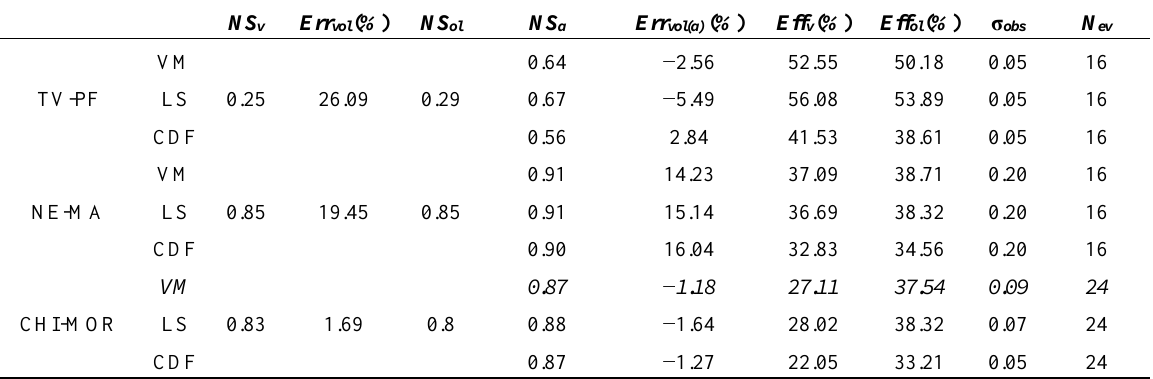
Table 3. Results of the data assimilation experiment for the five selected catchments on the selected flood events (number of events N ev ). NS val is the Nash Sutcliffe efficiency index calculated on the selected flood events from 2000–2009, NS ol refers to the same index calculated on the selected flood events on the ensemble mean, σ obs refers to the observation error (the same of Table 2) while NS a is the Nash-Sutcliffe efficiency index calculated after data assimilation on the selected flood events. Eff v and Eff o l refer to the results in terms of efficiency with respect to the validation and to the ensemble mean, respectively, calculated for the selected flood event. Gray cells in the table denote a deterioration with respect to the open loop